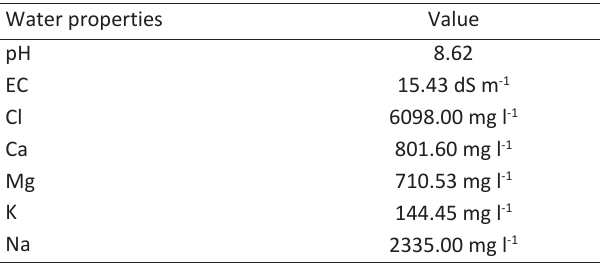
Table 2 - Chemical analysis of brackish water used for irrigation in the current research Water